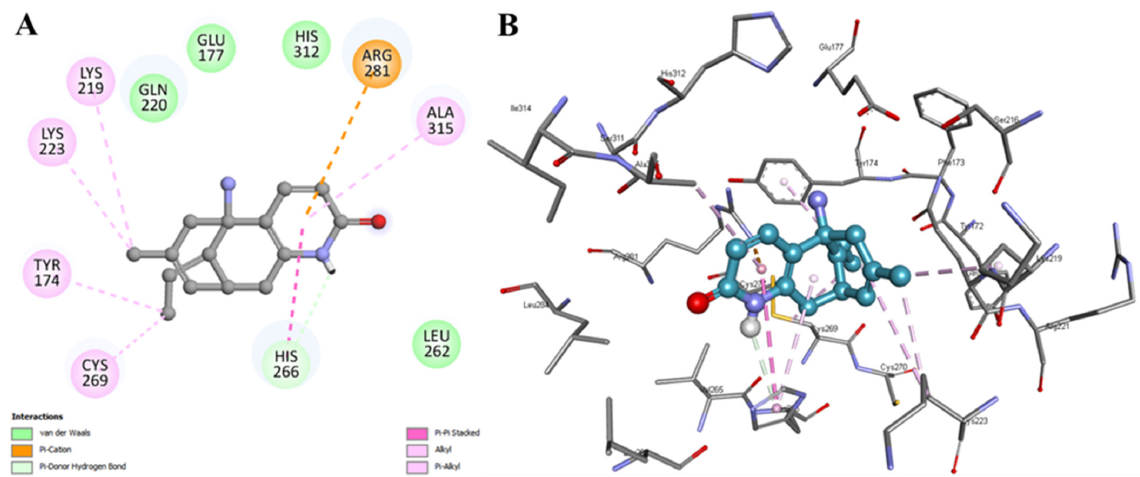
Figure 2. Detailed interactions of HSA with HpzA as ( A ) 2D and ( B ) 3D plots.